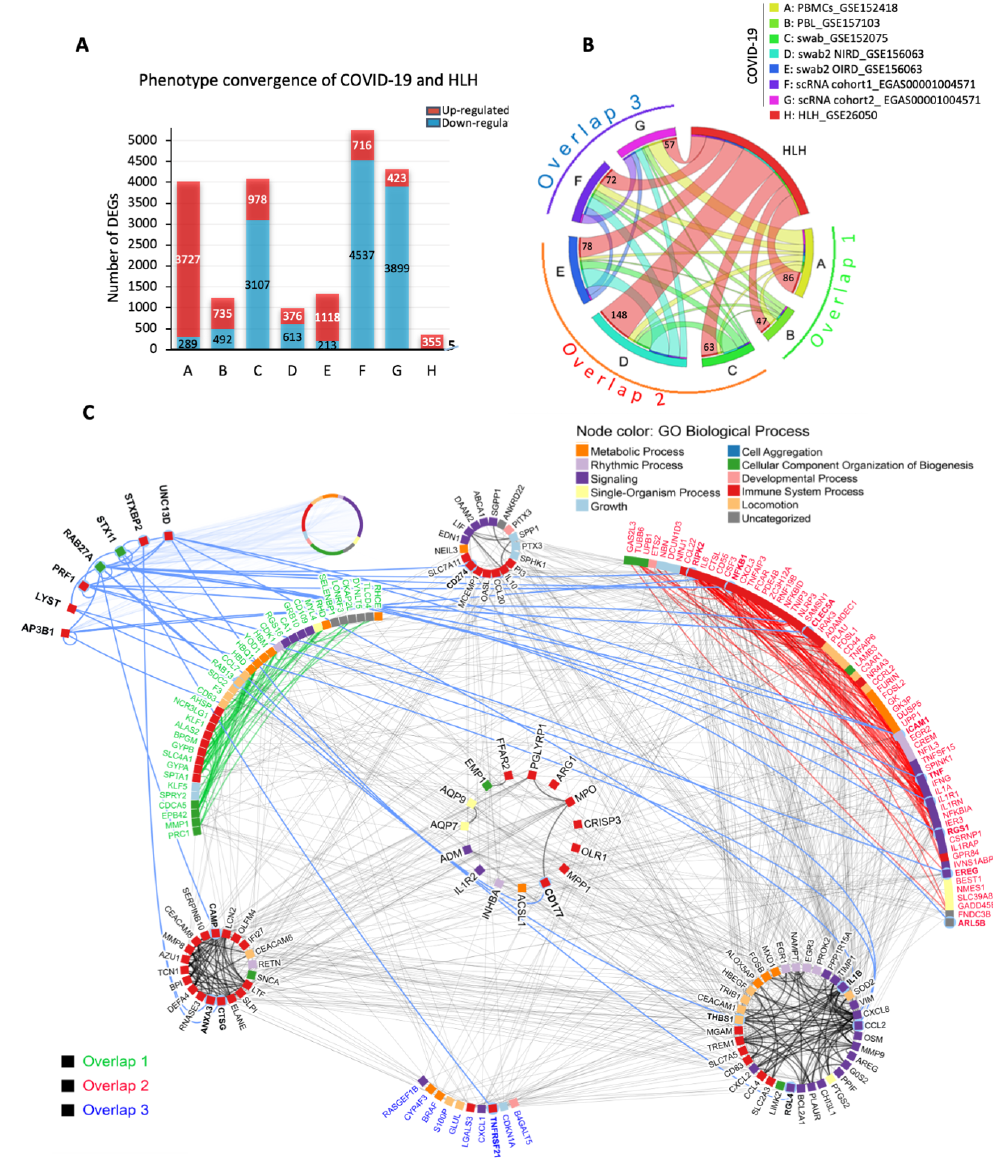
Figure 1. Transcriptional overlap between COVID-19 and HLH. ( A ) Number of differentially ex- pressed genes (DEGs, up- and down-regulated) by dataset. ( B ) Circos plot showing 237 common up-regulated DEGs between HLH and the different COVID-19 datasets (red lines: number at the end of each line indicates exact number of shared DEGs), divided into three overlapping subgroups (detailed in Supplementary Tables S2 and S3). The thickness of each line represents the number of genes shared between the different datasets. ( C ) Protein-protein interaction network among the 237 transcripts and seven genes causing HLH due to inborn errors of immunity (IEI). Node colours denote Gene Ontology Biological Processes. The label (gene name) colours represent transcripts from Overlap 1 (green), Overlap 2 (red), and Overlap 3 (blue). The center circle and side circles represent com- mon molecules across all three or two overlapping datasets, respectively. The upper left subnetwork represents the interactions between the seven genes associated with HLH and those from overlaps are in bold. The circle on upper left (gene names not shown) contains 1329 proteins connected by 217 interactions with the seven HLH/IEI-associated genes. The full network comprises 1538 proteins and 2522 direct physical interactions obtained from the IID database ver. 2021-05